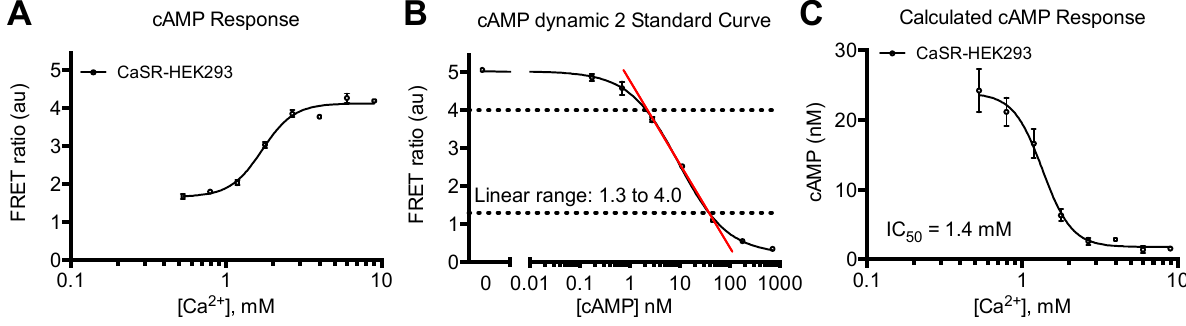
Figure 6. Characterization of calcium-induced G pathway activation in CaSR-HEK293 i cells using HTRF ® based assay. ( A ) Concentration-response curve of calcium in the presence of 5 µM forskolin using 2 × 10 4 cells/well and stimulation for 30 min at RT shown as FRET ratio. Increase in FRET signal is proportional to inhibition of cAMP production; ( B ) cAMP dynamic 2 standard curve showing concentration response curve of the cAMP standard diluted in a 1:1 mixture of Assay and Ligand buffer containing 1 µM IBMX and 10 µM forskolin; ( C ) Concentration-response curve of calcium in the presence of 5 µM forskolin shown as cAMP concentration. Data shown are calculated from the data in Panel A by the use of the standard curve in Panel B . Data are mean ± S.D. of triplicate determinations and representative for three independent experiments.